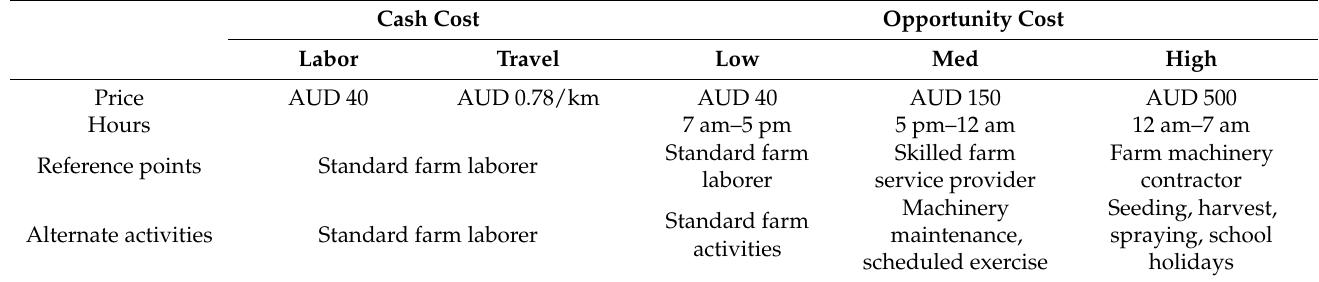
Table 1. Value of time used in the opportunity cost analysis. Costs were based on the perceived nuisance to farmers and conservative industry contract rates provided in Appendix A [29–32]. Cash